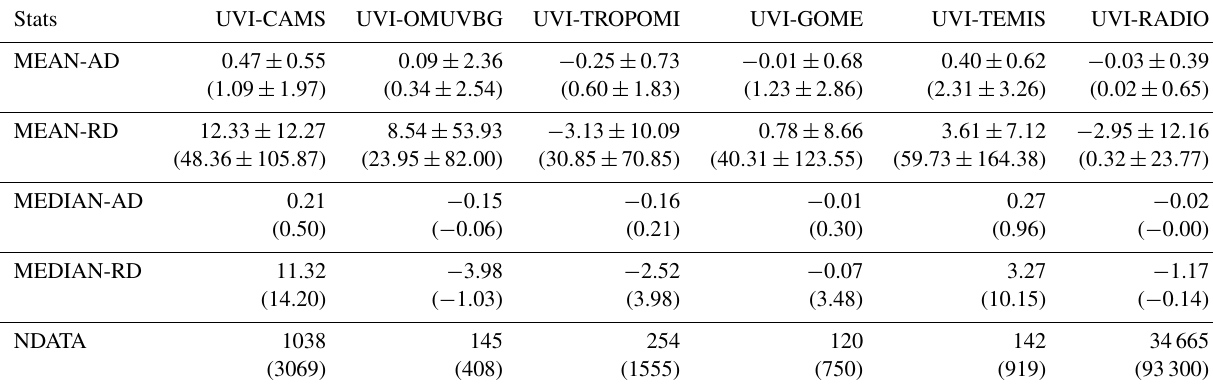
Table A1. Mean and median absolute and relative differences between CS-UVI satellite/model measurements and CS-UVI-BENTHAM at Saint-Denis. Mean and median absolute and relative differences between ALL-SKY-UVI satellite/model measurements and ALL-SKY-UVI- BENTHAM at Saint-Denis are in parentheses.